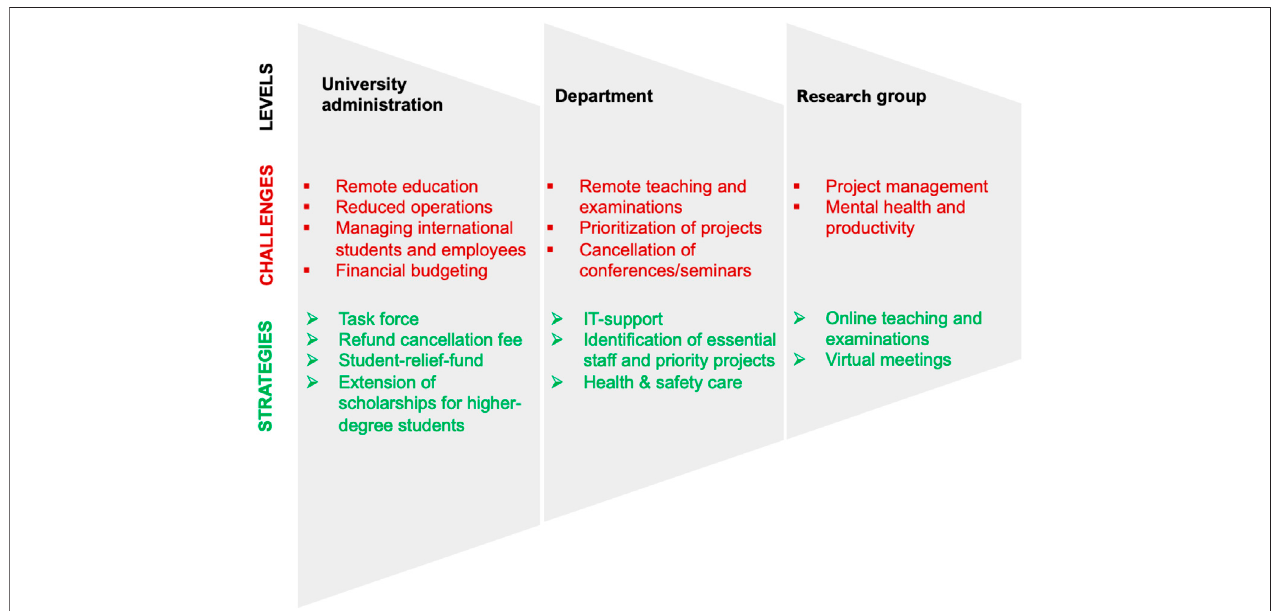
FIGURE 1 | List of key challenges academic organizations have faced, and strategies adapted due to the COVID-19 pandemic at different levels within an organization. For more information, read the Challenges and Strategies sections the paper.